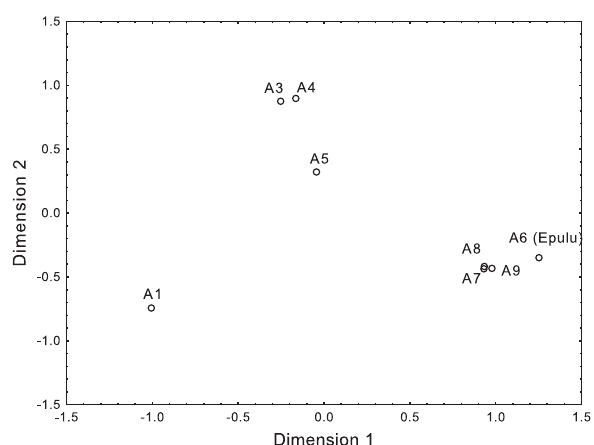
Fig. 3. Scatterplot of dimension 2 (19.87% of inertia) against dimension 1 (28.06% of inertia) of a correspondence analysis executed on a presence matrix (0–1) of recorded species in different parts of the Aruwimi basin; for delineation of the different parts, see Fig.